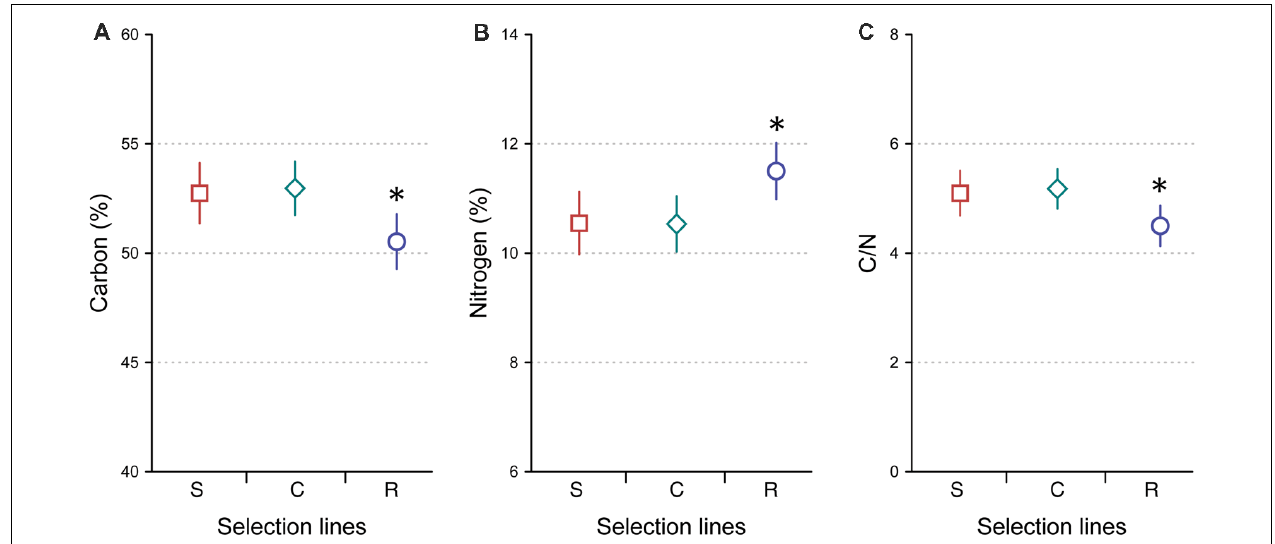
FIGURE 1 | Average carbon percentage (A) , nitrogen percentage (B) and carbon-to-nitrogen ratio (C) in Gryllus integer crickets selected for slow development (S, squares, n = 24), rapid development (R, circles, n = 29) and control developmental (C, diamonds, n = 30) lines. Error bars represent 95% confidence intervals. Asterisks indicate significant differences between the lines ( ∗ P <